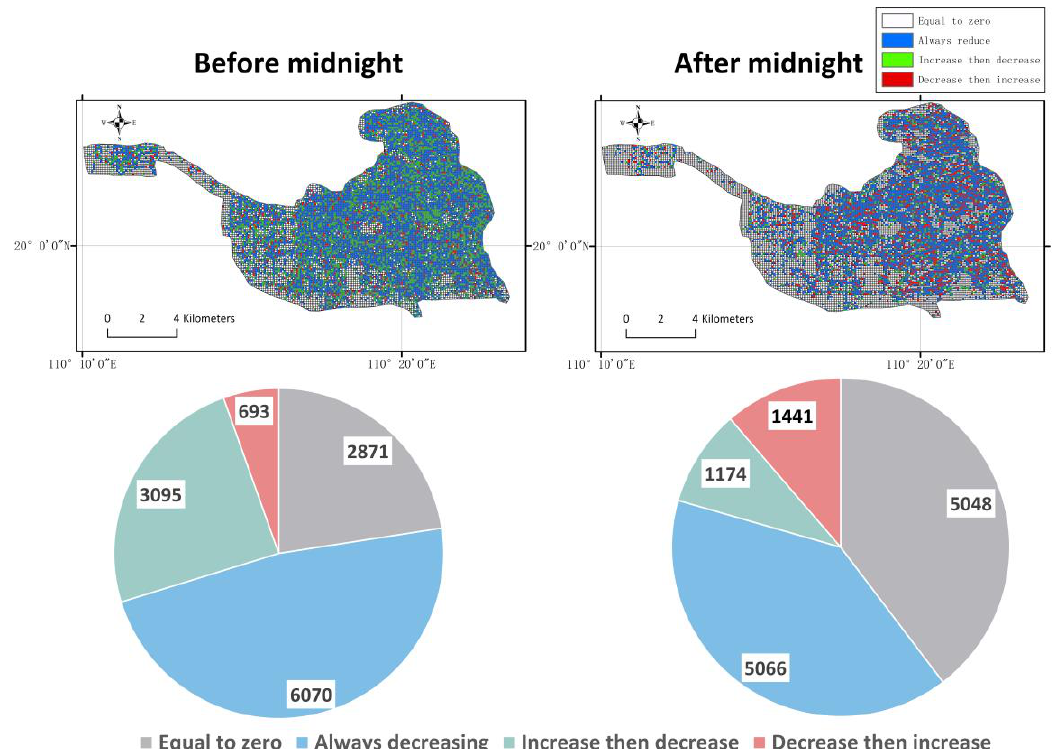
Figure 8. The distribution diagram of crowd flows’ changes before and after midnight in downtown Haikou. The left side shows the geographical distribution and clustering geogrid quantity statistics for the crowd flows’ changes in “ before midnight ”, and the right side shows the crowd flows’ changes in “ after midnight ” .